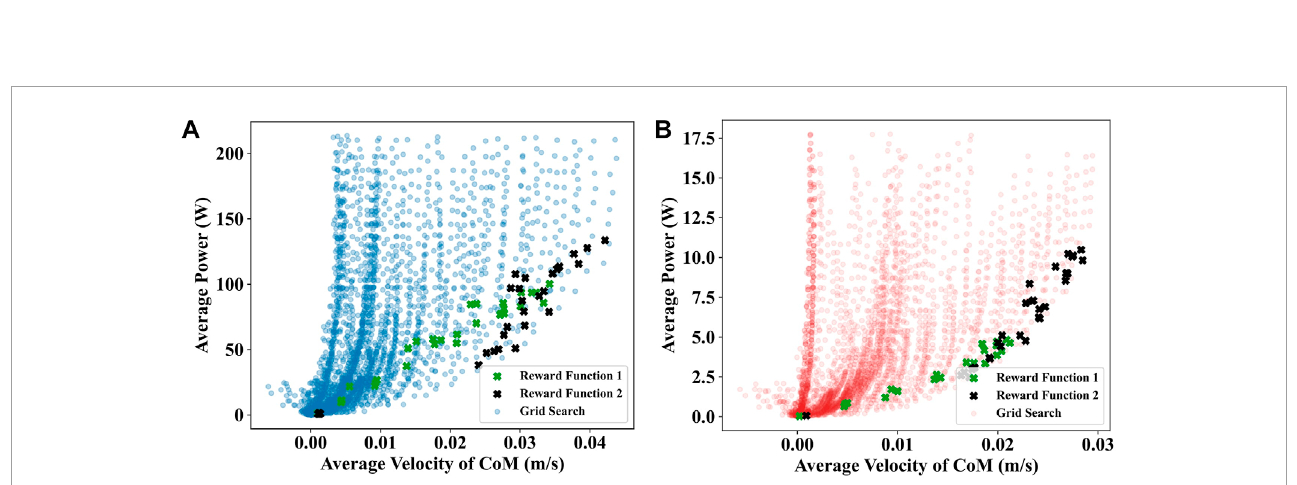
FIGURE 6 (A) Comparision of the testing result of deep reinforcement learning controllers and gait equation controllers for rigid snake robot. (B) Comparision of the testing result of deep reinforcement learning controllers and gait equation controllers for soft snake robot. The plots with reward functions are corresponding to the deep learning solutions.